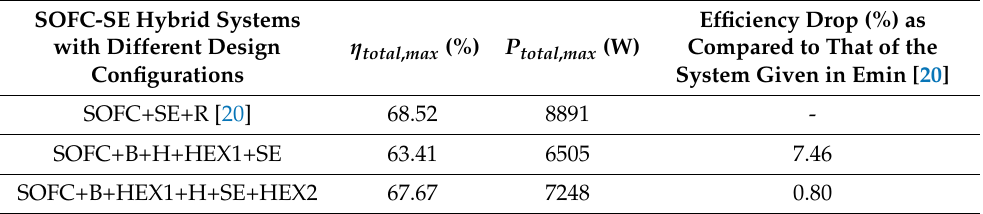
Table 2. Maximum system efficiency and power generated when system operated at 873 K.